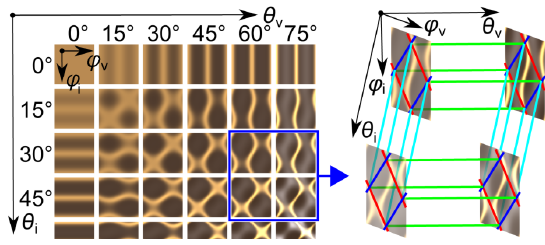
Fig. 2 Visualization of a BRDF with highlighted axial (red), diagonal (blue), horizontal (green), and vertical (cyan) slices. Note that the BRDF is a four-dimensional continuous function and that its axes are